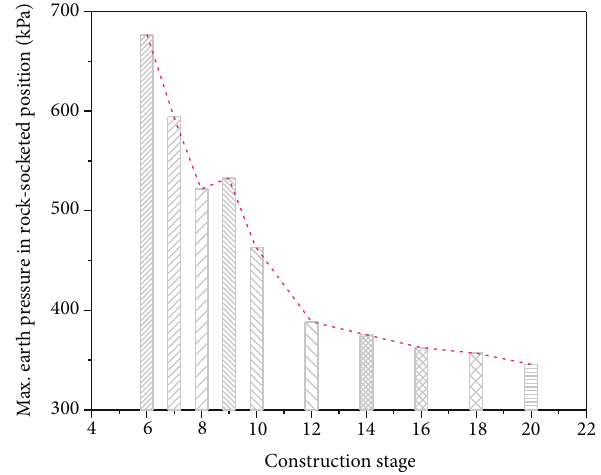
Figure 18: Variation of maximum earth pressure in the rock- socketed position with the construction